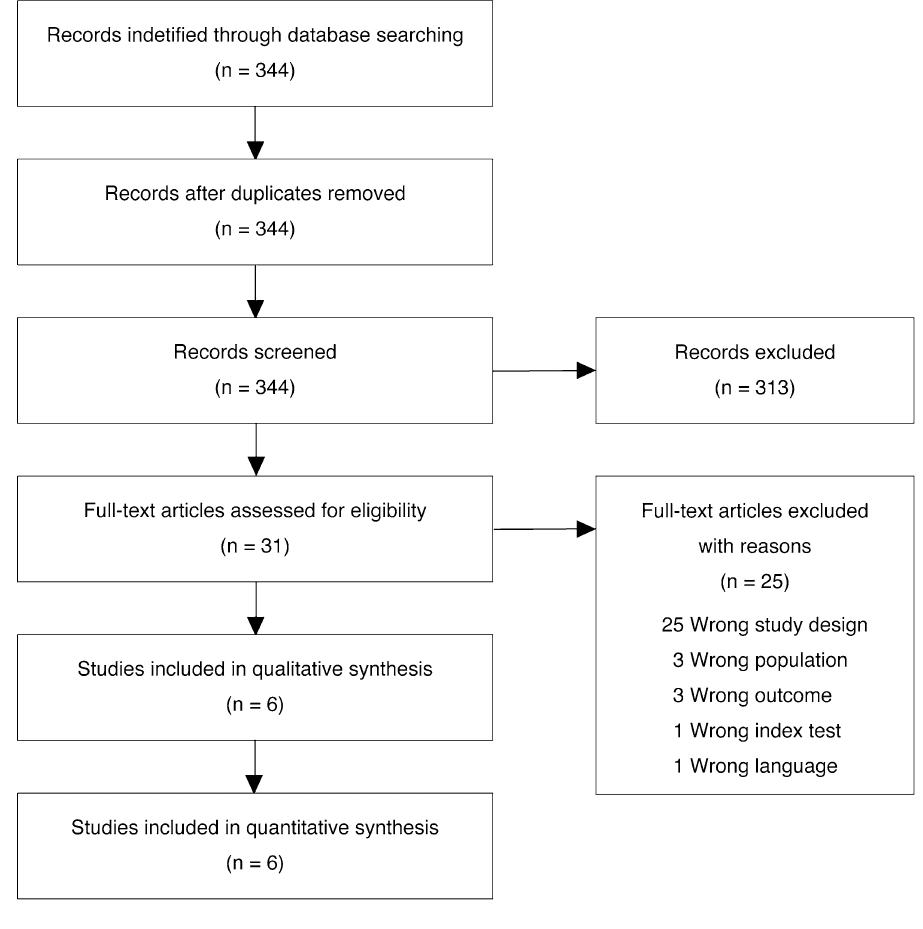
Figure 1. Flow diagram of the study